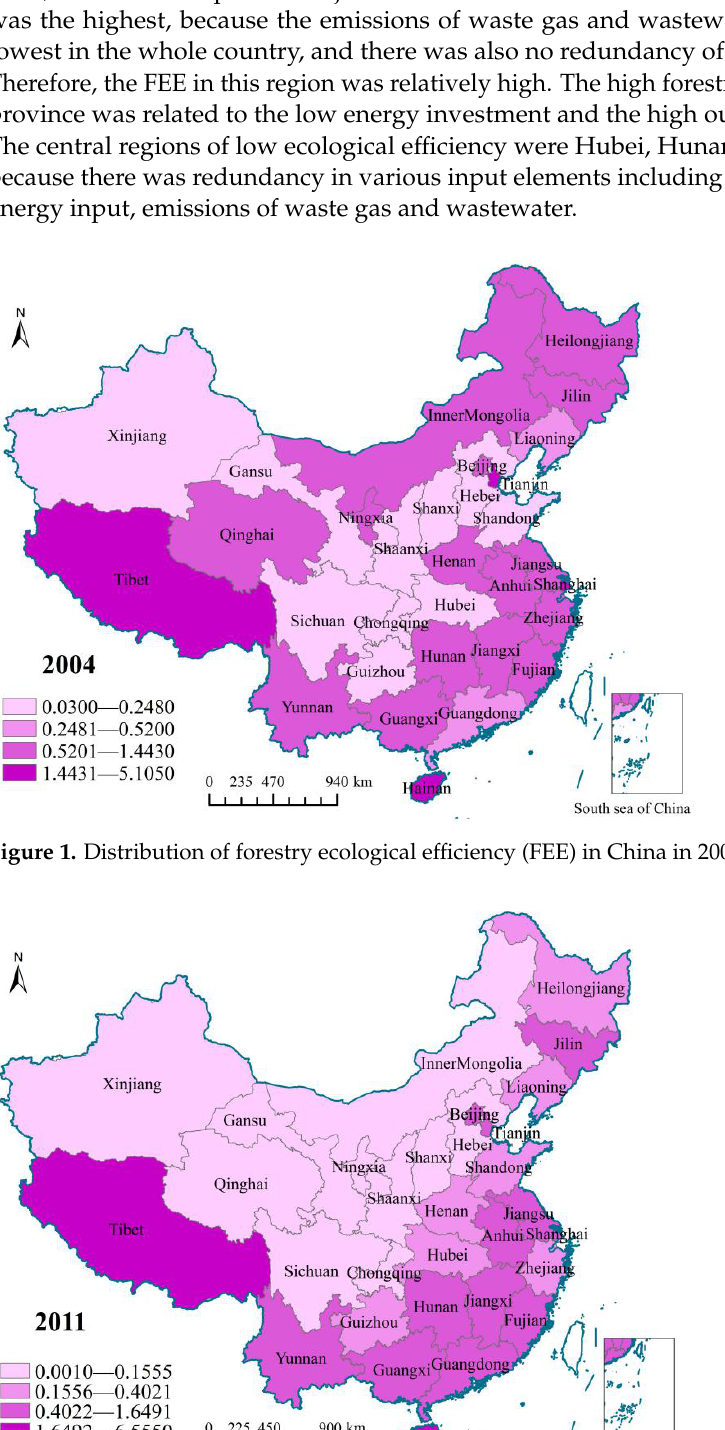
Figure 3. Distribution of forestry ecological efficiency (FEE) in China in 2018. In Figure 1, China’s FEE of the northeast and the south was higher, and FEE of China’s middle regions was relatively lower. The FEE of Shanghai and Tianjin ranked top in the east region, the reason was that forestry area and forestry practitioners had no seri- ous redundancy. Moreover, the total forestry output value of Shanghai reached 13.14 tril- lion yuan, the timber output of Tianjin was about 40 thousand cubic meters. The FEE in Tibet was the highest, because the emissions of waste gas and wastewater in Tibet were the lowest in the whole country, and there was also no redundancy of forestry practition- ers. Therefore, the FEE in this region was relatively high. The high forestry efficiency of Hainan province was related to the low energy investment and the high output value of forestry. The central regions of low ecological efficiency were Hubei, Hunan, Shaanxi, and